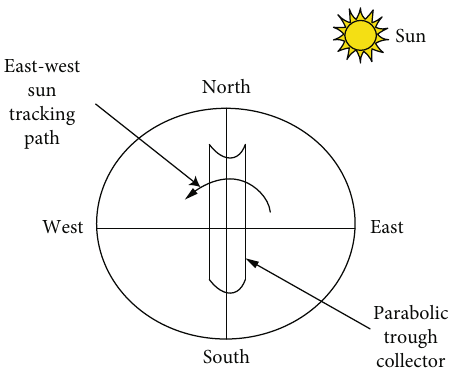
Figure 3: Diagrammatic representation of PTC sun tracking